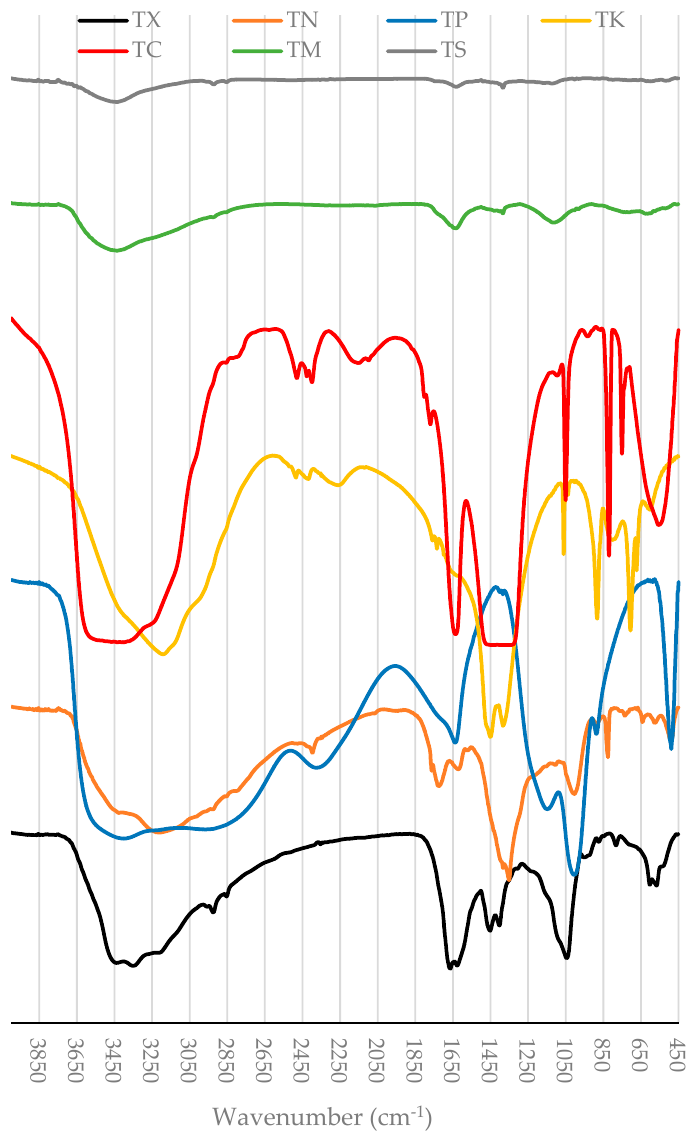
Figure 1. IR spectra of the MCT ® fertilizers used in the work.